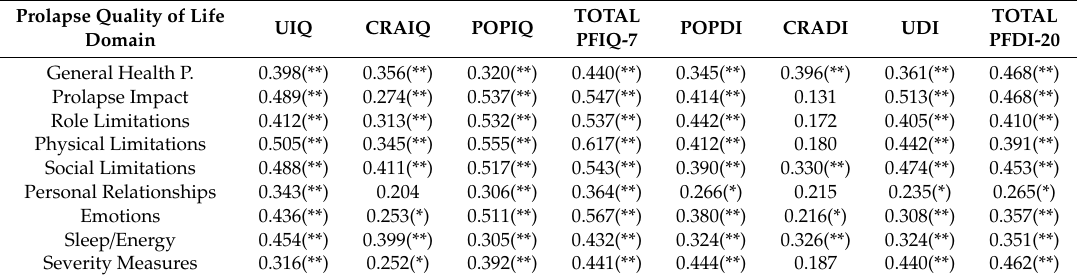
Table 2. Results from the analysis of convergent construct validity (Spearman´s coe ffi cient (r)) for Prolapse Quality of Life Questionnaire (P-QoL) with Pelvic Floor Impact Questionnaire (PFIQ-7) and Pelvic Floor Distress Inventory (PFDI-20) total and dimensions (N = 100). TOTAL TOTAL Prolapse Quality of Life POPDI CRADI UDI UIQ CRAIQ POPIQ PFDI-20 PFIQ-7 Domain General Health P.